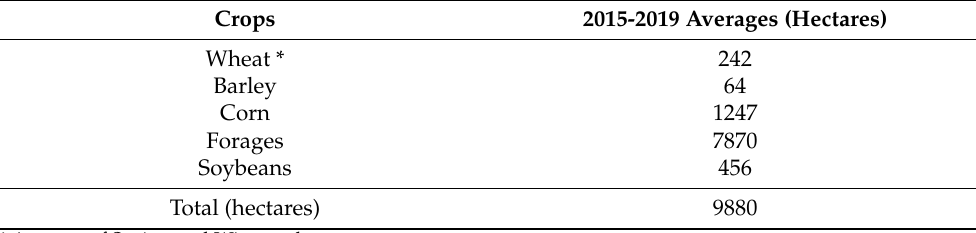
Table 5. Five year averages of crops produced on the dykelands of Nova Scotia. Crops 2015-2019 Averages (Hectares) Wheat * 242 Barley 64 Corn 1247 Forages 7870 Soybeans 456 Total (hectares)